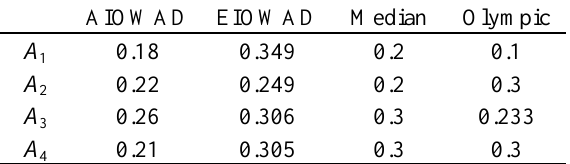
Table 5. Aggregated results 2